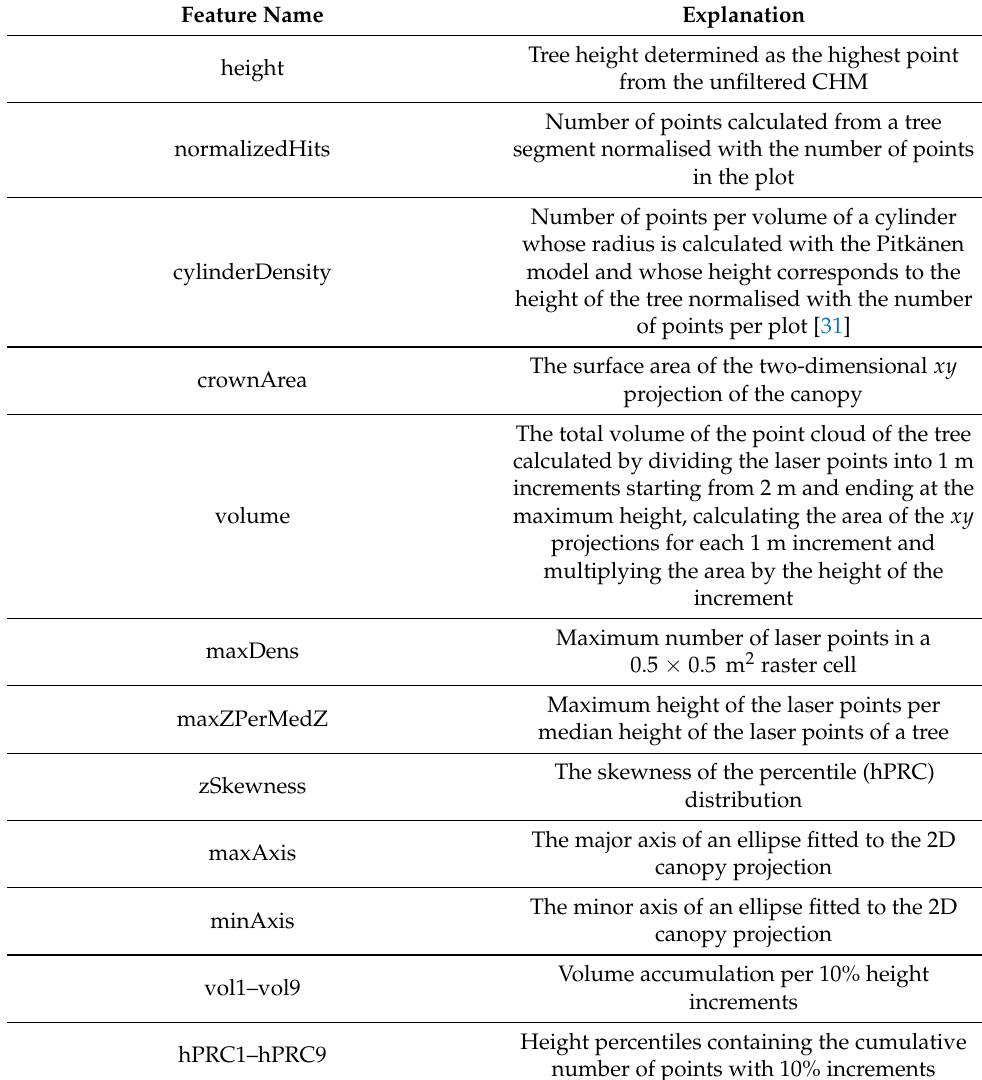
Table 4. Single-time tree-level features extracted from the point cloud data. Some of the features are based on Yu et al. [29].